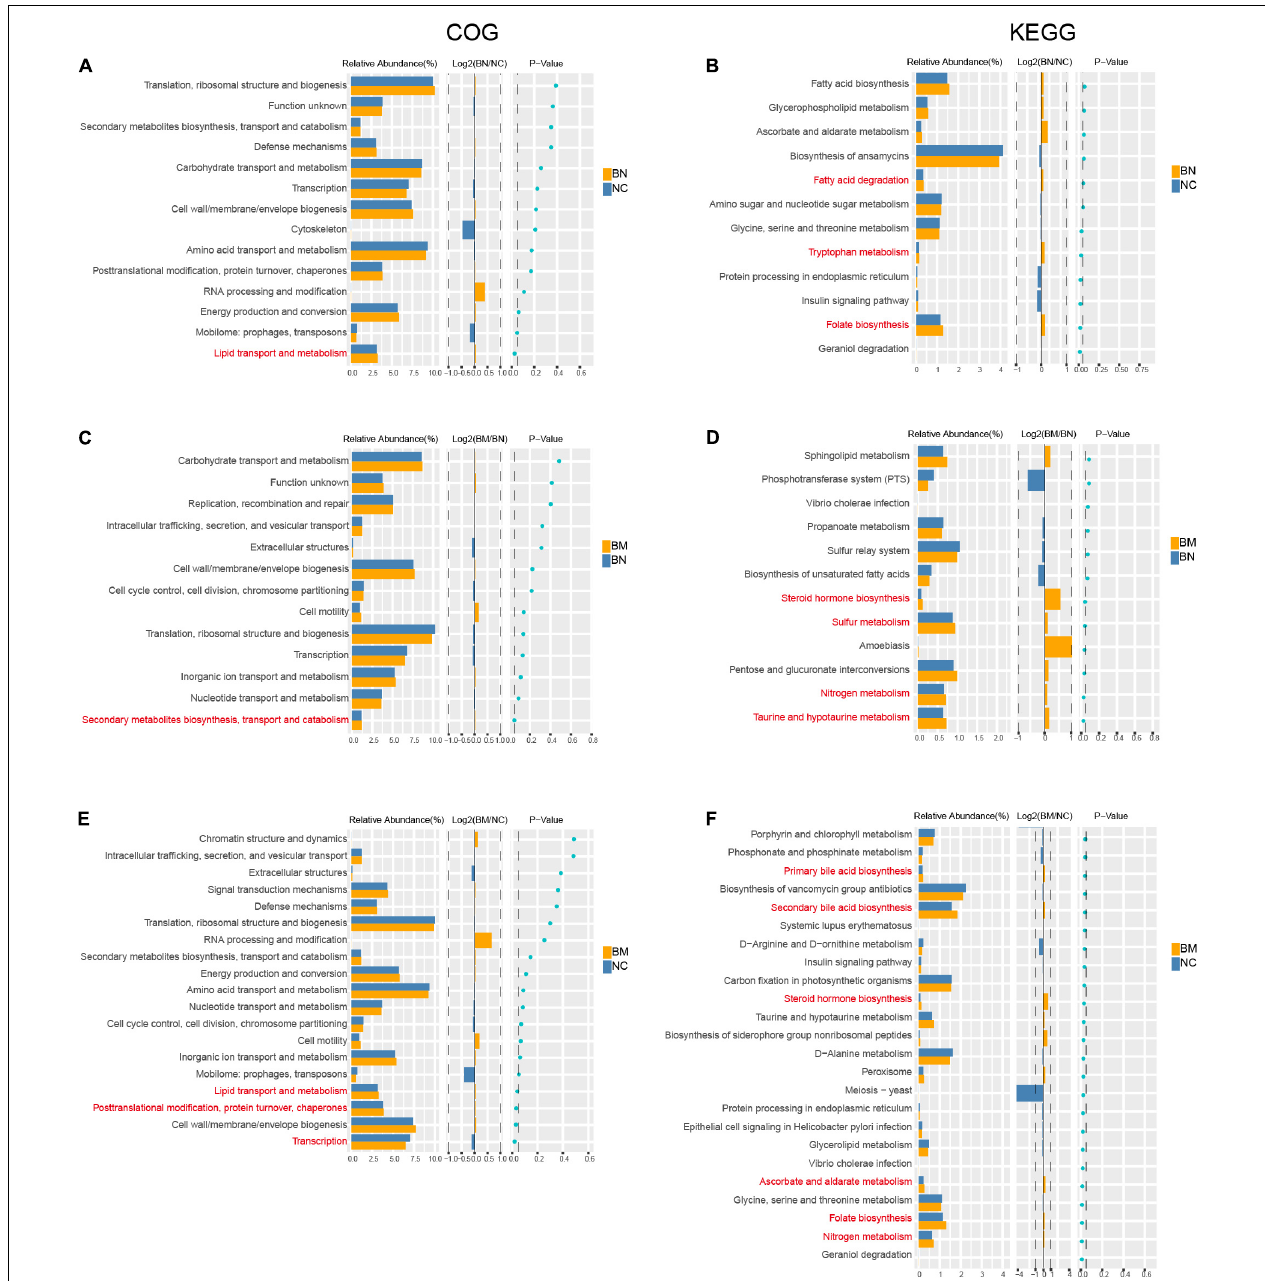
FIGURE 5 | Predicted biological processes mediated by differential gut microbiota based on COG and KEGG analysis. (A,B) COG and KEGG analyses of the differential biological processes caused by distinct gut microbiota profiles between NCs and BNs. (C,D) COG and KEGG analyses of the differential biological processes caused by distinct gut microbiota profiles between BNs and BMs. (E,F) COG and KEGG analyses of the differential biological processes caused by distinct gut microbiota profiles between NCs and BMs. P < 0.05 is considered significantly different.